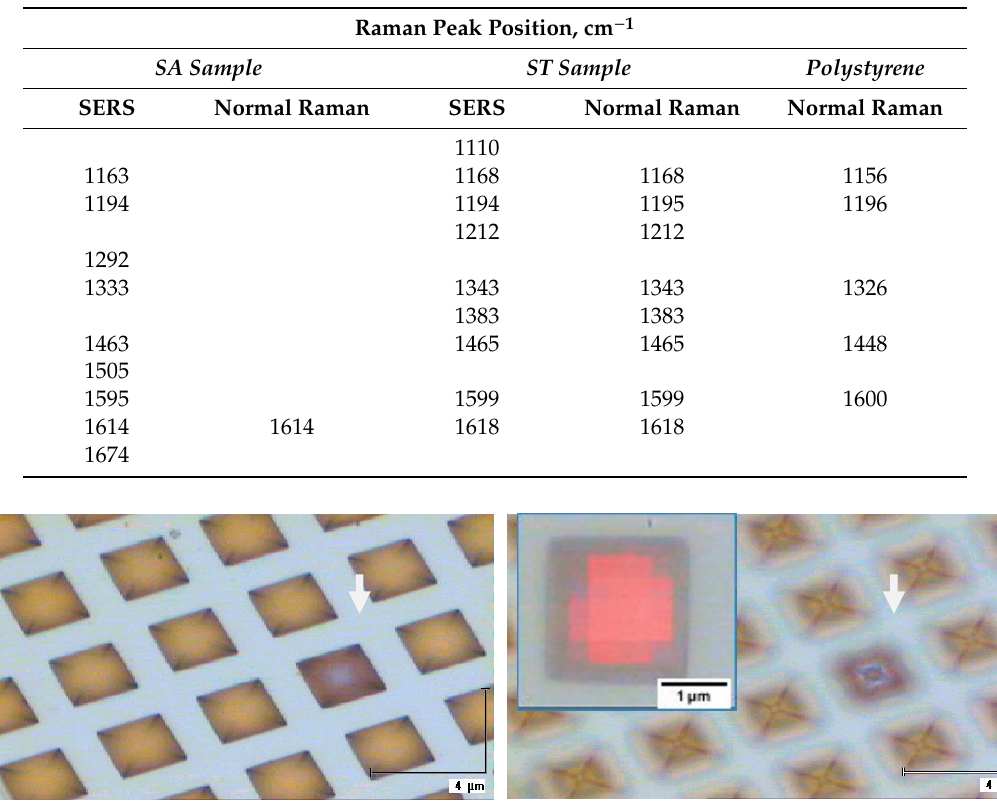
Figure 8. Optical microscopic images recorded with microscope focused on the top and the bottom of the inverse pyramid SERS array. The arrow shows the location of the microbead in one of the voids. The insert shows the Raman map as an overlay.